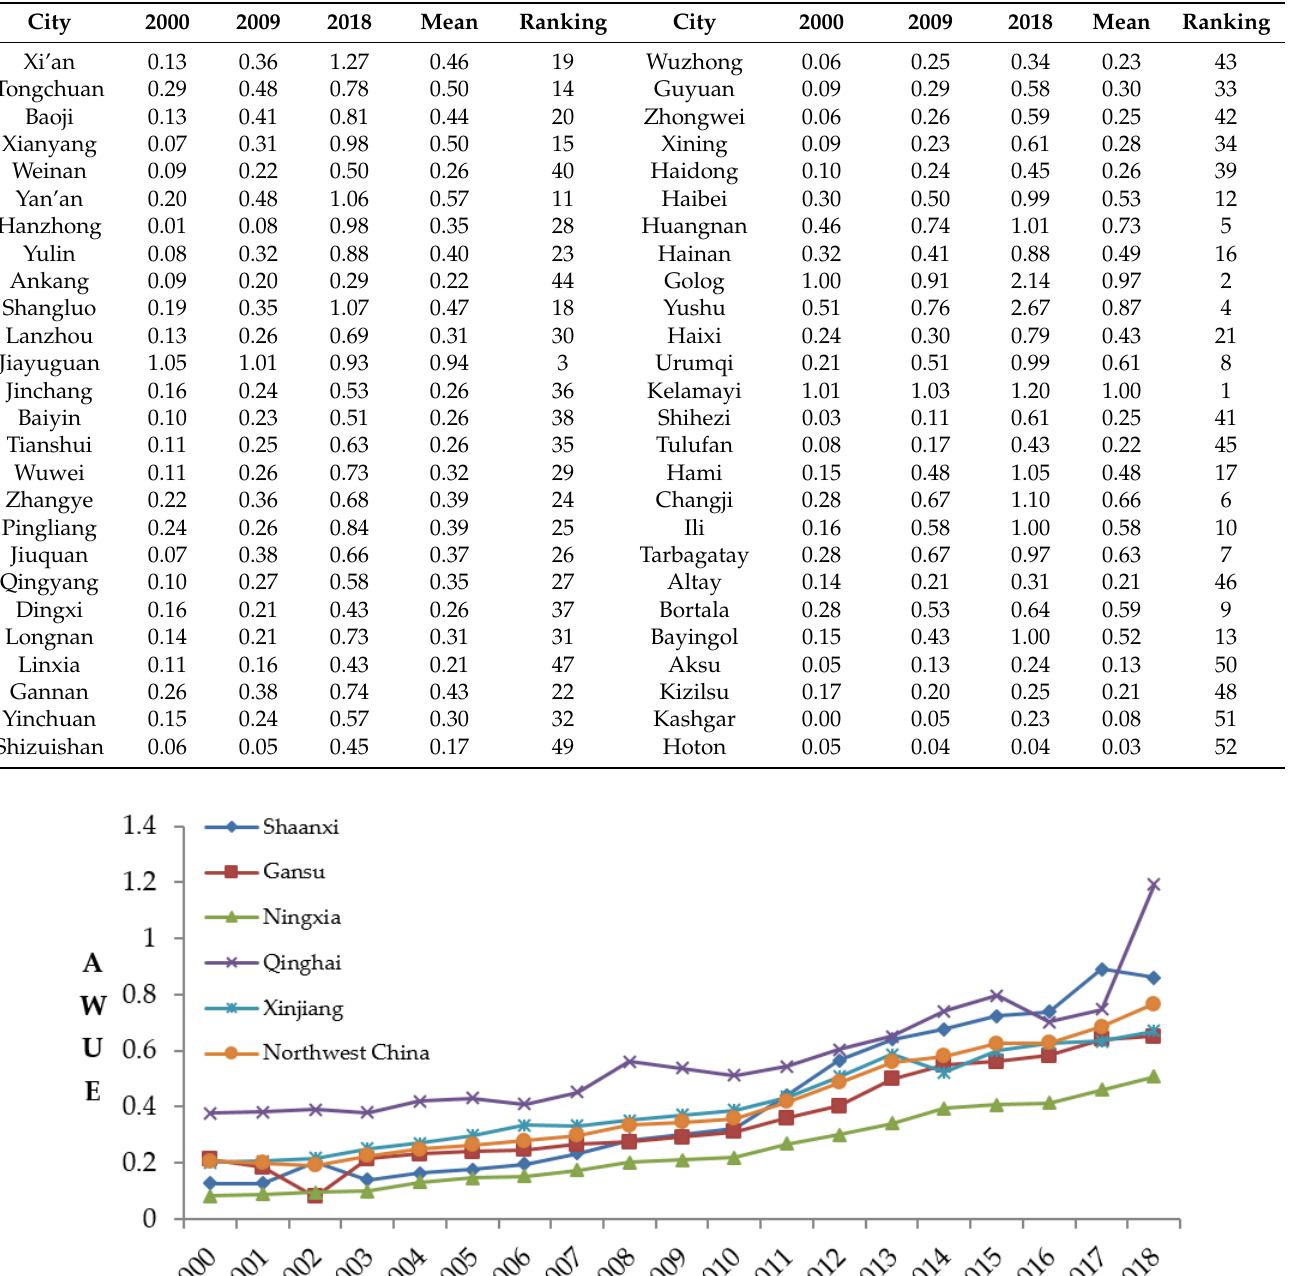
Table 3. AWUE and ranking by region from 2000 to 2018.